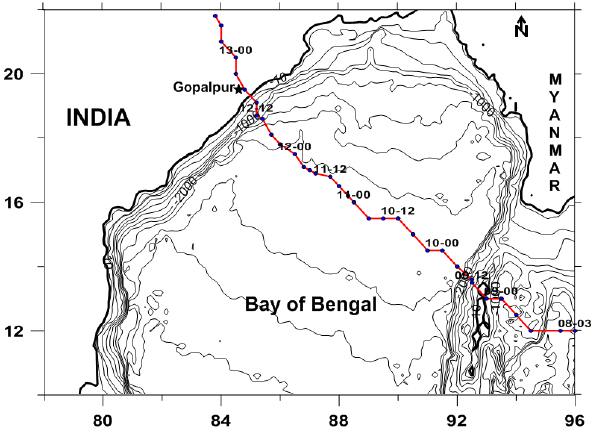
Figure 2. Cyclone track (solid circle) connected with straight line and Waverider buoy location (star) at different time on 12 Octo- ber 2013. The time in UTC is indicated near the